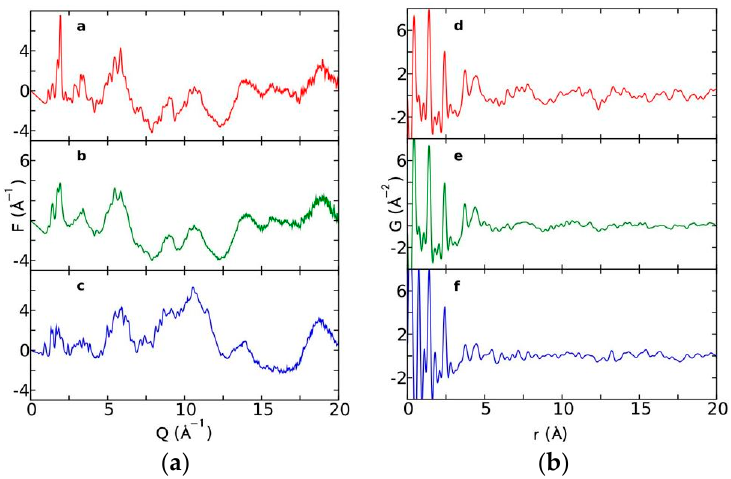
Figure 9. ( a ) Total scattering diffraction patterns and ( b ) PDFs of the various carbamazepine (CBZ) samples; a and d correspond to crystalline CBZ form III, b and e correspond to the amorphous CBZ